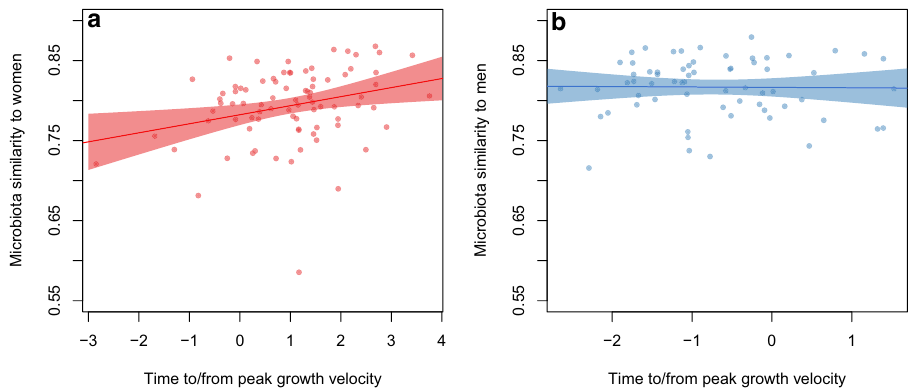
Figure 1. ( a ) Microbiota similarity to that in adults in relation to pubertal timing (time to/from peak growth velocity) in girls. ( b ) Microbiota similarity to that in adults in relation to pubertal timing (time to/from peak growth velocity) in boys.